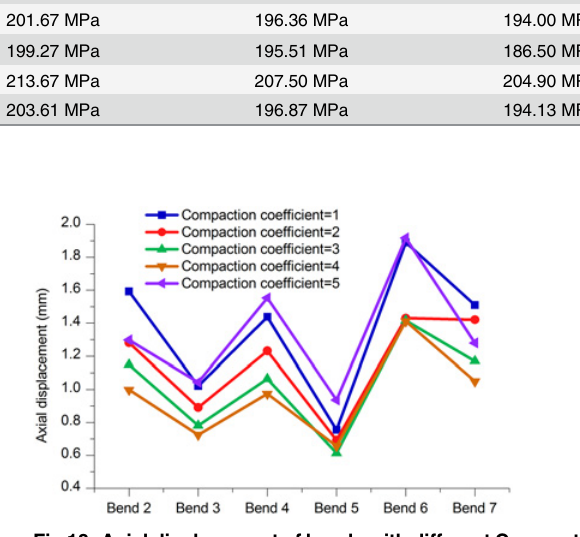
Fig 18. Axial displacement of bends with different Compaction coefficients.